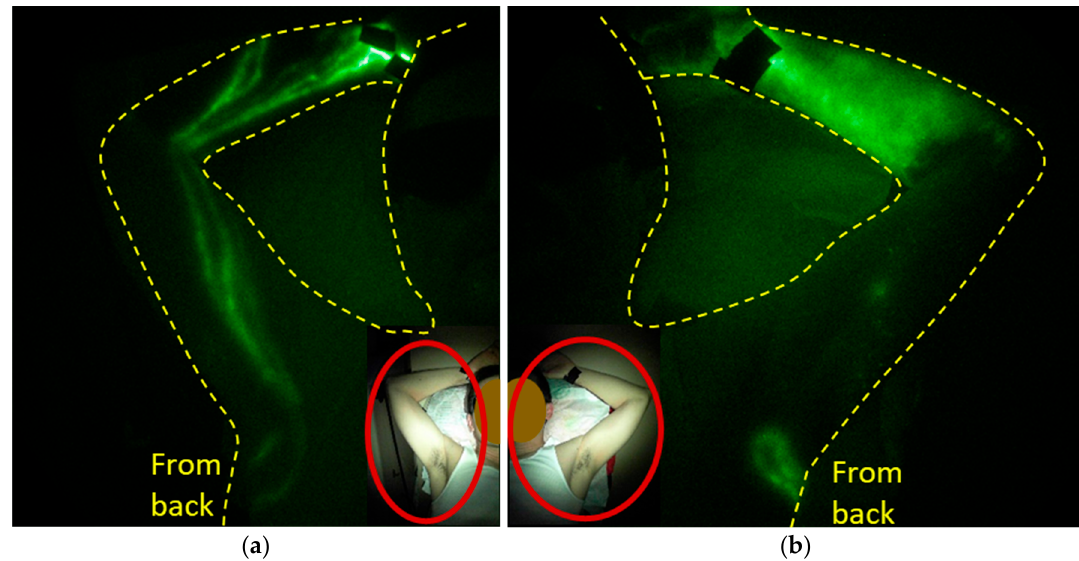
Figure 11. ( a ) Unaffected and ( b ) affected arms of a subject with chronic joint pain with suspected autoimmune disorder. Injection sites are covered with round bandages and / or black vinyl tape. The brightness and contrast of the images have been adjusted to facilitate the visualization of the 16-bit imaging depth.